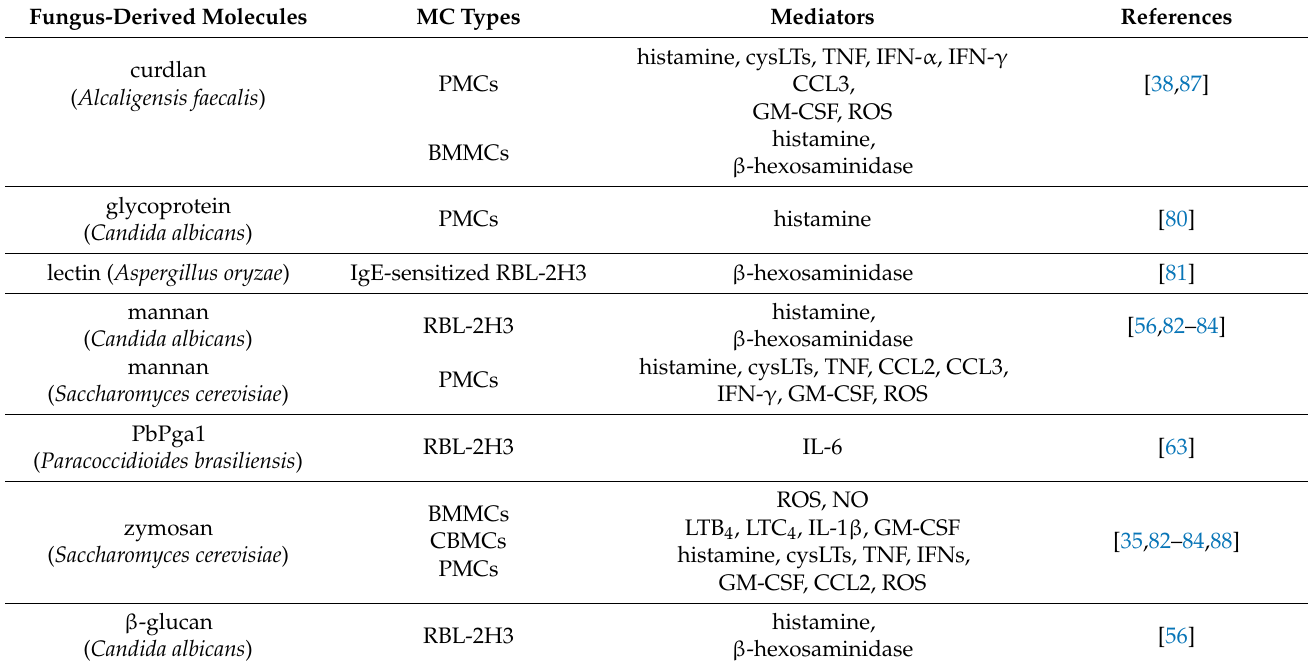
Table 2. The influence of fungus-derived molecules on MC mediator